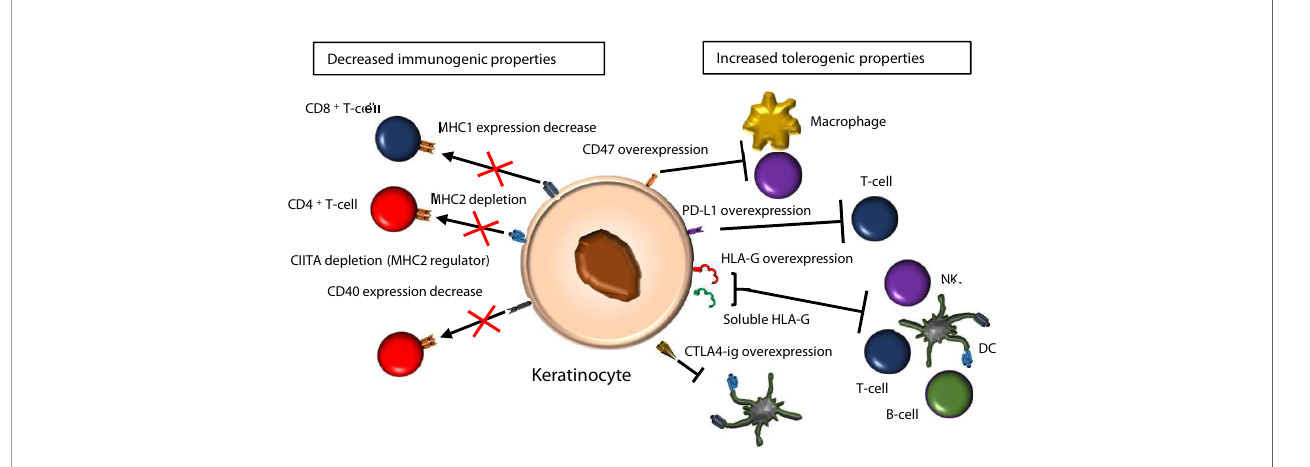
FIGURE 2 | Candidate immunomodulatory strategies in epidermis. There are two main strategies to reduce keratinocyte immunogenicity for epidermis grafting. The fi rst one is to decrease MHC1, MHC2 and co-stimulatory molecules such as CD40, which limits the ability of keratinocytes to present antigens to T-cells. The second one is to overexpress HLA-G and other immune checkpoint molecules (CD47, PD-L1, CTLA4), to increase